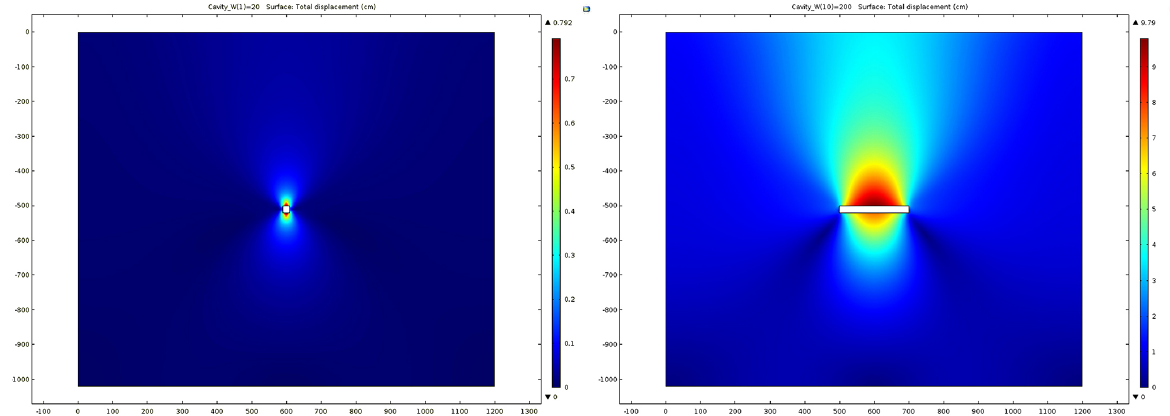
Figure 8. Total strata displacement around a medium seated cavity.